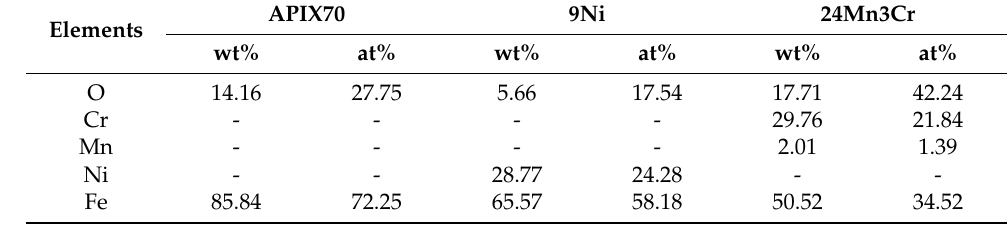
Figure 6. FE-SEM images of the tested samples immersed in an acidic solution for 28 days. ( a – c ) Surface images of APIX70, 9Ni, and 24Mn3Cr, respectively; ( d – f ) Cross-sectional images of APIX70, 9Ni, and 24Mn3Cr, respectively; ( g – i ) Magnified view of ( d – f ). Table 5. EDS quantitative analysis at each point marked on Figure 6. Table 5. EDS quantitative analysis at each point marked on Figure 6.